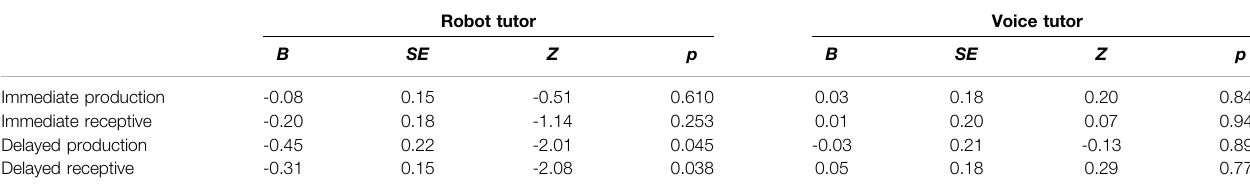
TABLE 3 | GLMMs with NARS as the sole predictor for the four post-lesson scores.